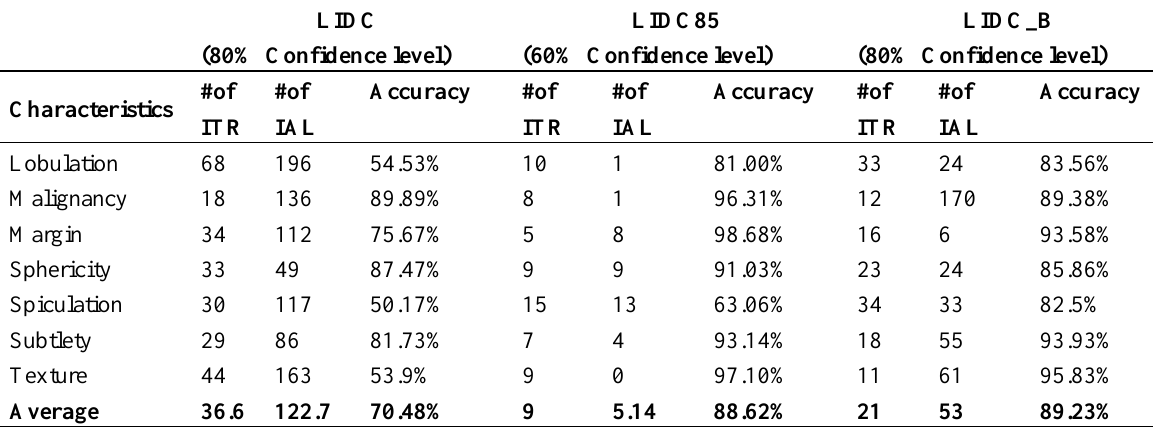
Table 6. Classification accuracies of the ensemble of classifiers built using decision trees; the number of classifiers ( ) was set to 10 and number of artificially generated size C examples ( ) to 1; #of ITR stands for number of iterations of Active-DECORATE, and size R #of IAL stands for number of instances added to the training data later (those that did not reach the confidence